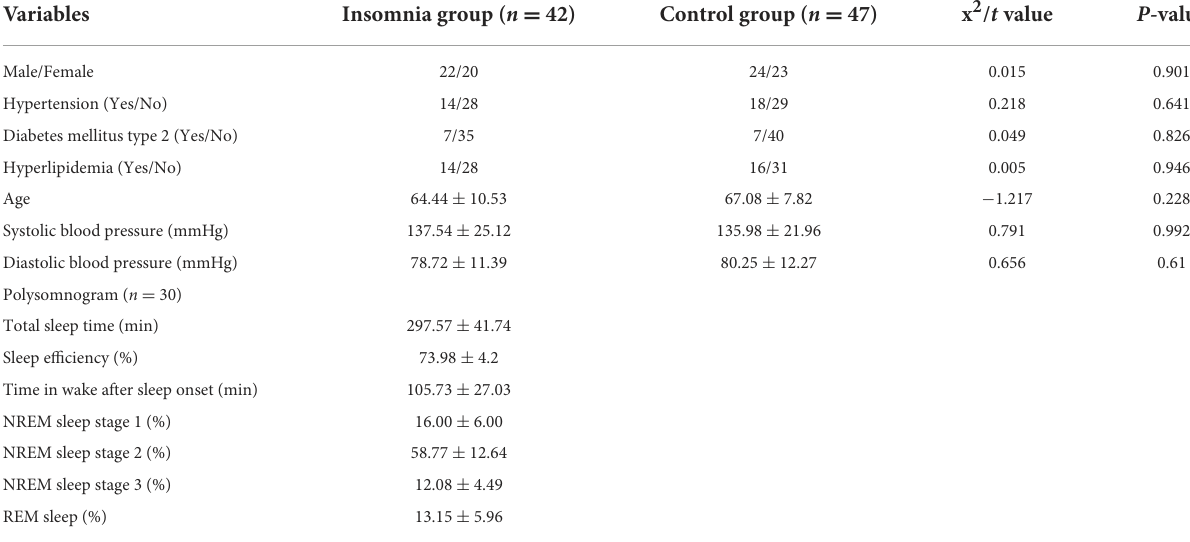
TABLE 1 Comparison of general data between the two